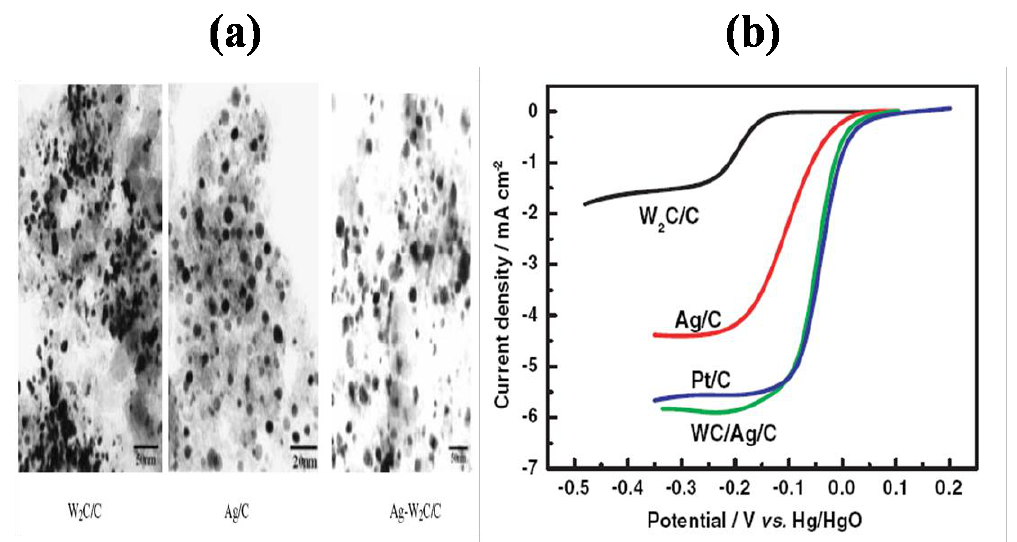
Figure 11. (a) TEM images and (b) half cell results for oxygen reduction (Reprinted from Reference 99 with